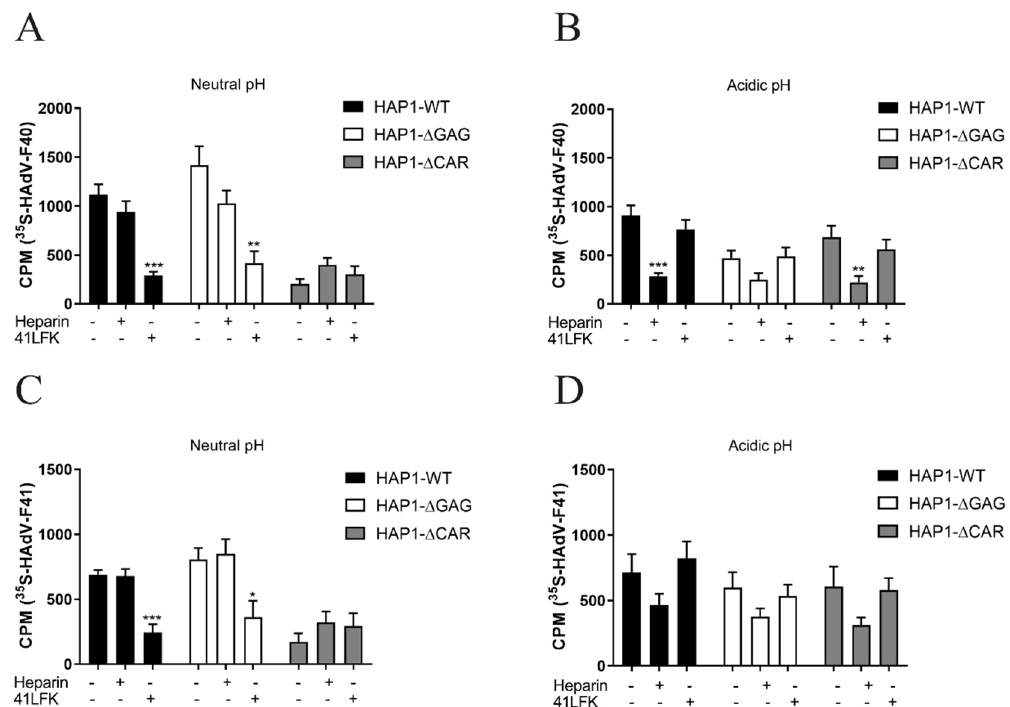
Figure 5. Effect of pH treatment on receptor usage: 35 S-labeled HAdV-F40 and HAdV-F41 virion binding to HAP1 WT cells, HAP1- ∆ GAG cells and HAP1- ∆ CAR cells. The parental cell line HAP1 WT expresses glycosaminoglycans (GAGs) and CAR. HAP1- ∆ GAG lacks expression of GAGs, while HAP1- ∆ CAR lacks expression of CAR. ( A ) Untreated (neutral pH) HAdV-F40 or ( B ) acidic pH treated HAdV-F40 or ( C ) untreated (neutral pH) HAdV-F41 or ( D ) acidic pH treated HAdV-F41 were preincubated with heparin and cells were preincubated with 41LFKs before binding. Binding to cells was quantified as counts per minute (CPM) by a liquid scintillation counter. All experiments were performed three times with duplicate samples in each experiment. Error bars represent mean ± SEM. * P < 0.05, ** P < 0.01 and *** P < 0.001 versus control.